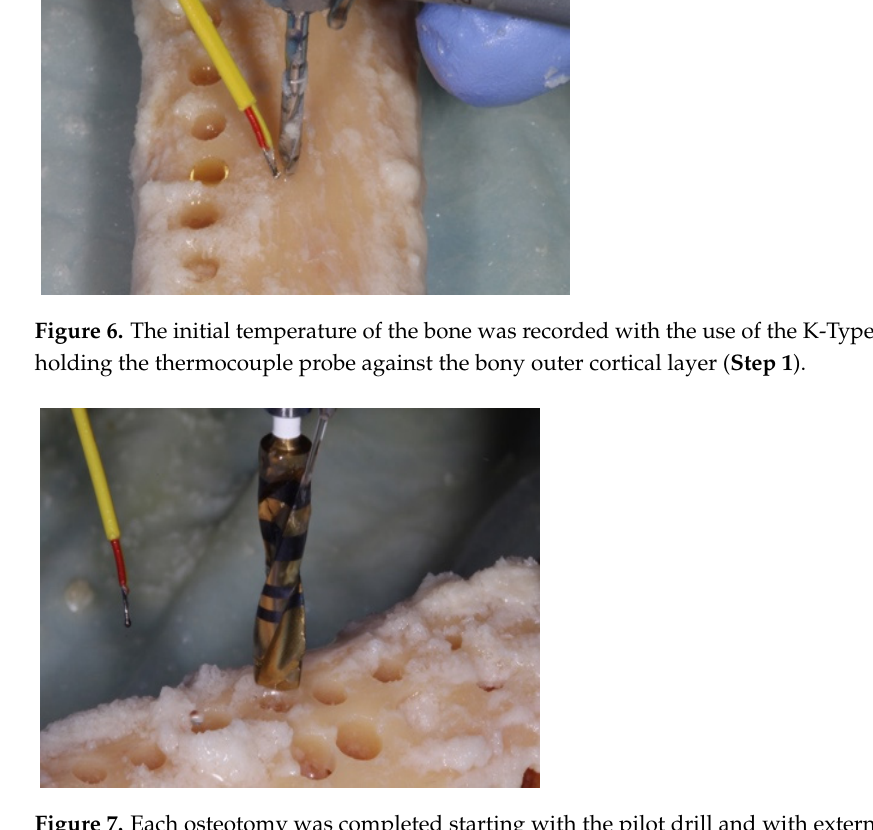
Figure 7. Each osteotomy was completed starting with the pilot drill and with external irrigation at each of the 800, 1000, or 1200 RPM drilling speeds ( Step 2 ).